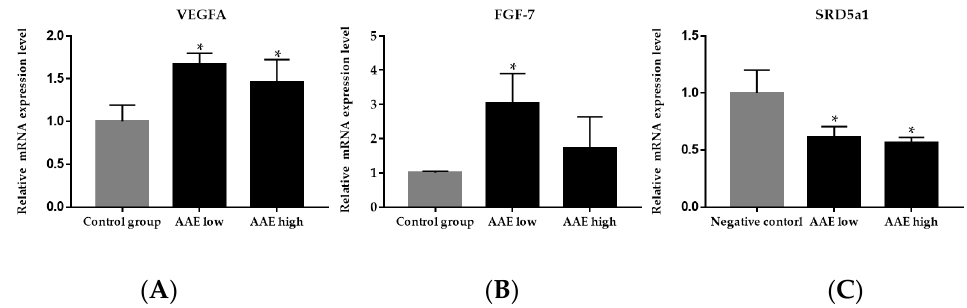
Figure 3. Relative mRNA expression of VEGFA and FGF 7 in C57BL/6 mice. The skin tissues of mice were collected after three weeks of treatment. The expression of VEGFA ( A ) and FGF-7 ( B ) were higher in the AAE-treated group compared to that in the control group. The expression of genes VEGFA and FGF-7 were higher in the AAE low group (160 mg/kg/d) than AAE high group (320 mg/kg/d). Gene expression of ( C ) SRD5a1 showed a dose-dependent decrease in AAE low and high groups compared to the control group; * p < 0.05 compared with the control group. VEGFA , vascular endothelial growth factor A; FGF 7, fibroblast growth factor 7.